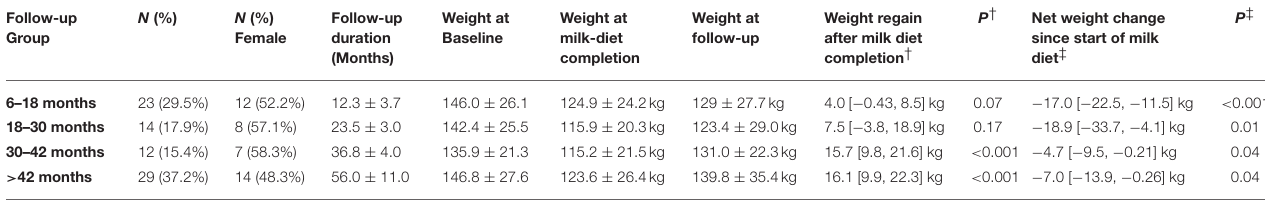
Weight at follow-up